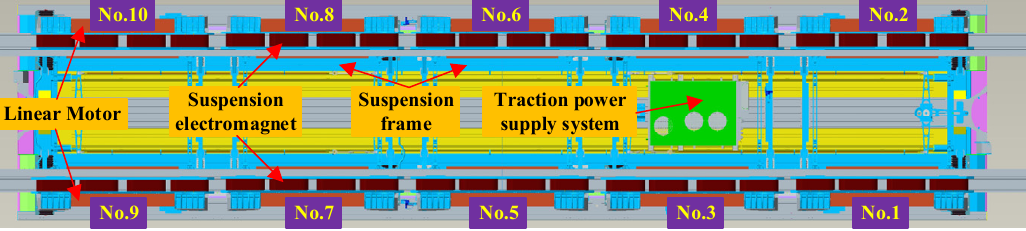
Figure 1. Schematic diagram of underbody structure of the medium- and low-speed maglev train.